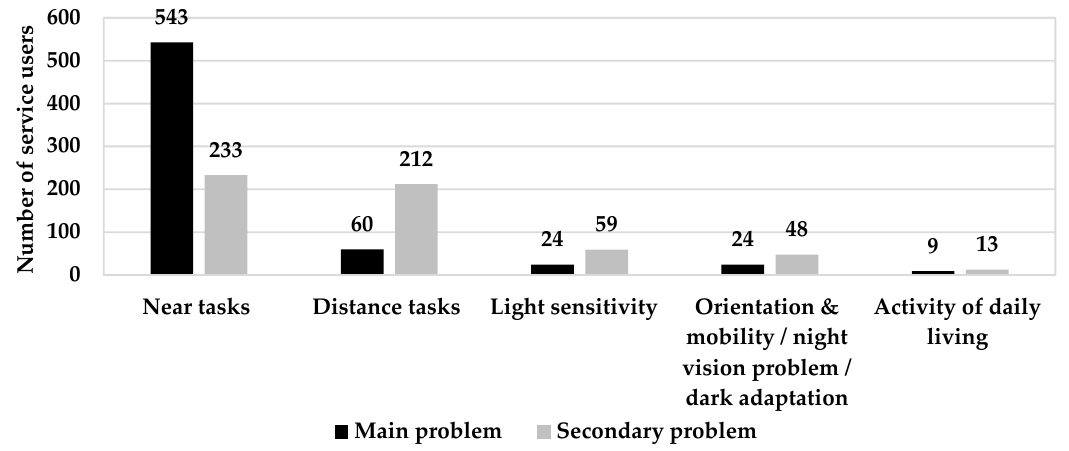
Figure 3. Main and secondary functional problems of service users. Near tasks include reading, writing, work tasks, and technology use. Distance tasks include watching TV, seeing the class board, seeing signs, face recognition, and driving. Light sensitivity includes glare, photophobia, and sun sensitivity. The numbers do not sum up to the sample size (725) since 65 subjects did not report any main or secondary functional problem and 95 subjects did not report any secondary functional problem.